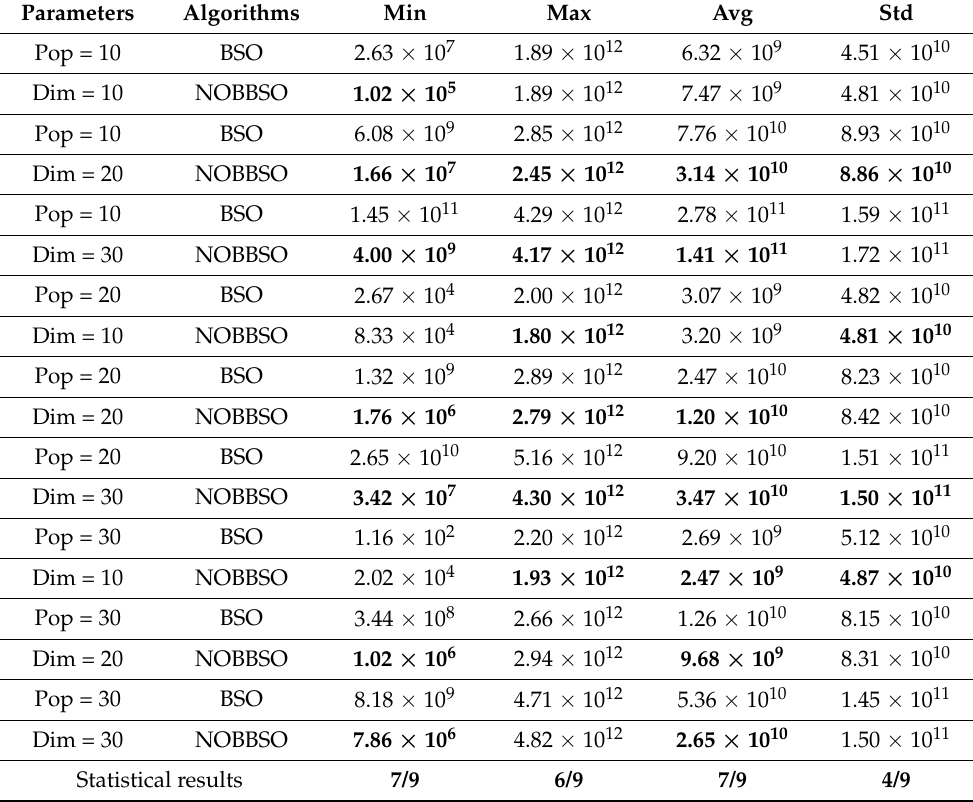
Table 2. The analysis of parameters.